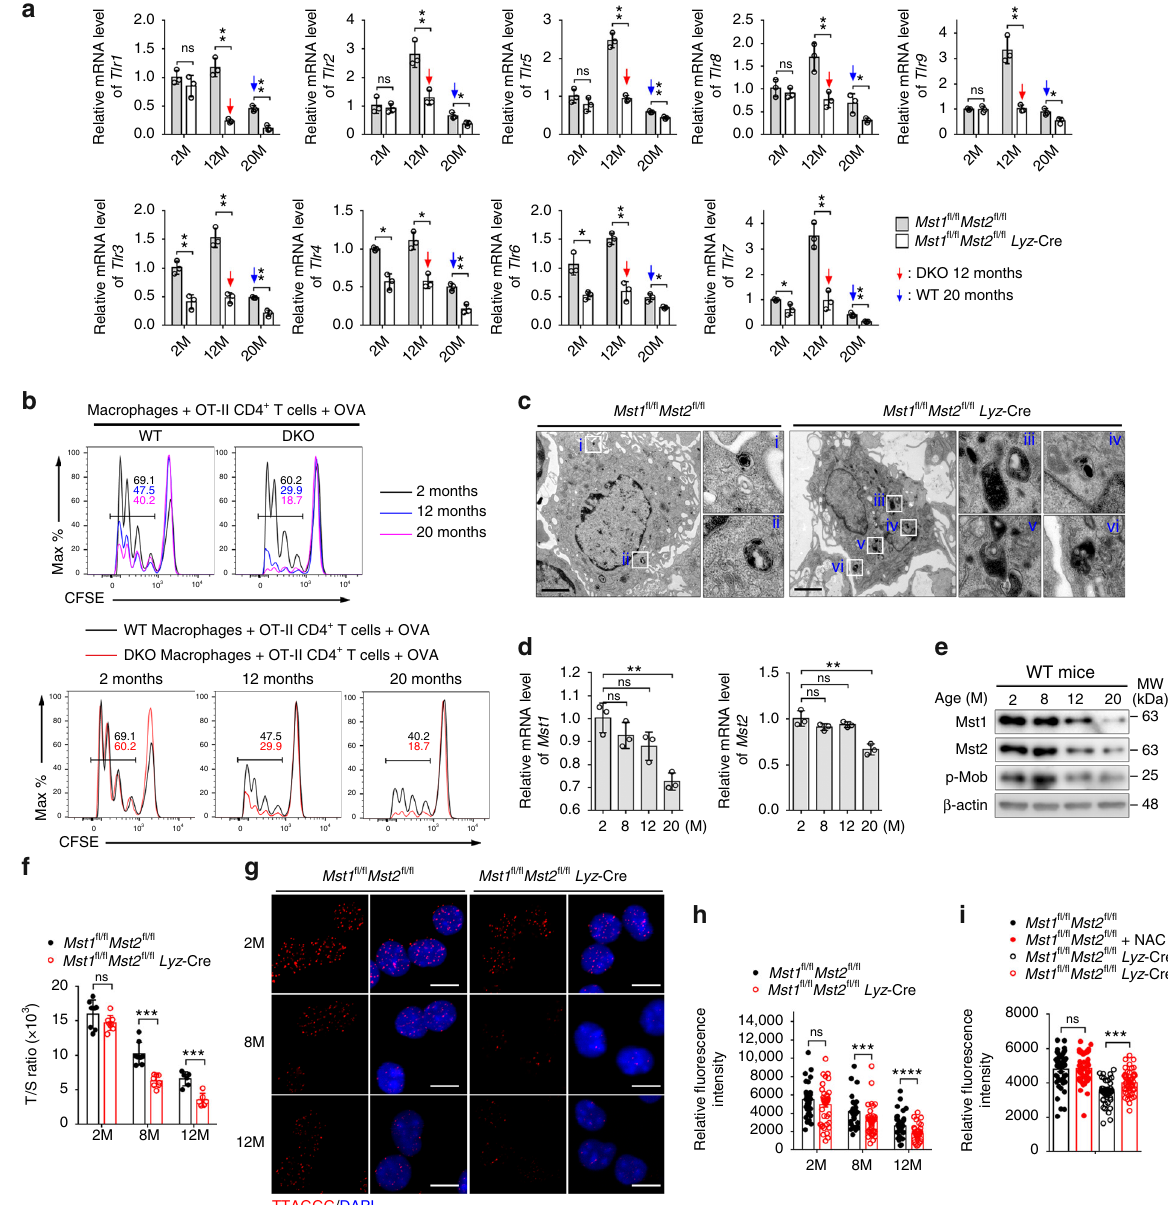
Fig. 2 Loss of Mst1/2 promotes ageing in macrophages. a RT-qPCR analysis of various Tlrs genes on peritoneal macrophages isolated from Mst1 fl / fl Mst2 fl / fl (WT) or Mst1 fl / fl Mst2 fl / fl Lyz -Cre (DKO) mice with indicated age. b Proliferation assay of CFSE-labeled CD4 + OT-II T cells co-cultured with WT and DKO BMDMs in presence of OVA protein. c Representative transmission electron micrographs (TEMs) of lipofuscin granules within peritoneal macrophages isolated from 12-month-old WT and DKO mice. ×25 magni fi cation of areas outlined in the main images as indicated. Scale bars, 2 μ m. d , e RT-qPCR analysis of Mst1 and Mst2 (d), and immunoblot analysis of Mst1, Mst2 and p-Mob ( e ) in peritoneal macrophages isolated from WT mice with indicated age. f – h The relative telomere length (T/S ratio) ( f ), representative fl uorescence microscopy images of telomere FISH analysis (red) and nuclei (blue) ( g ), and relative fl uorescence intensity of telomere FISH ( h ) in peritoneal macrophages isolated from 2-, 8-, or 12-month-old WT and DKO mice. Scale bars, 10 μ m. i Relative fl uorescence intensities of telomere FISH in peritoneal macrophages isolated from WT and DKO mice with or without NAC supplementation in drinking water for 7 months. ns, not signi fi cant ( P > 0.05); ** P < 0.01, *** P < 0.001, **** P < 0.0001, compared as indicated (Student ’ s t test). Data are from one experiment representative of three independent experiments with similar results (mean and s.d. of n = 3 ( a , d , experimental replicates); n = 5 ( f , biological replicates); mean and s.e.m. of n = 50 ( h , i , experimental replicates))